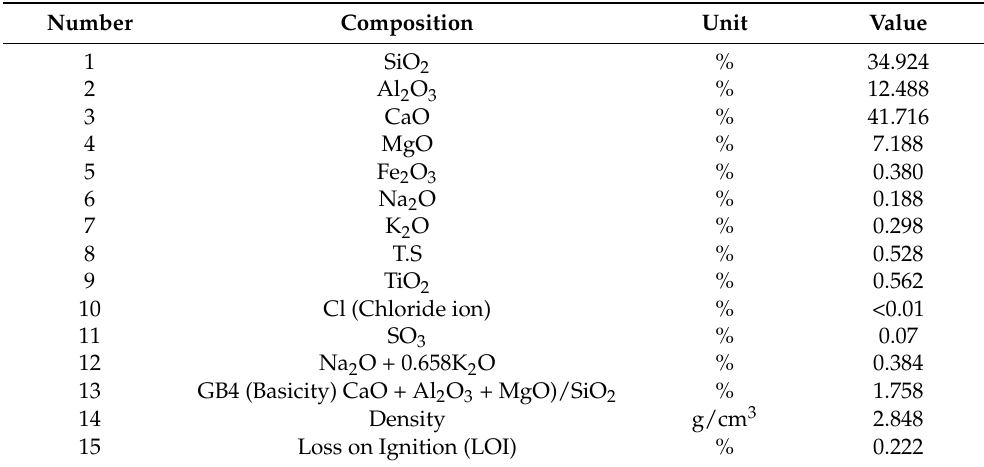
Table 2. Chemical composition of